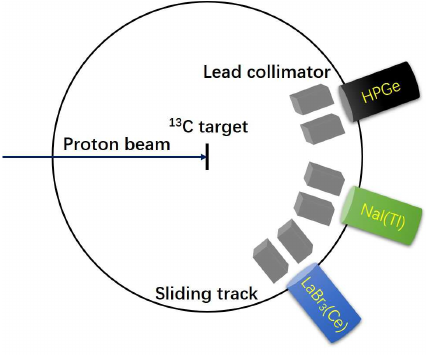
Figure 3. Experiment setup of 197 Au( γ , n) reaction measurement O ffl ine measurements were taken in a low background shielding system including a HPGe detector. The detector relative e ffi ciency is 105% for the 1.332 MeV gamma